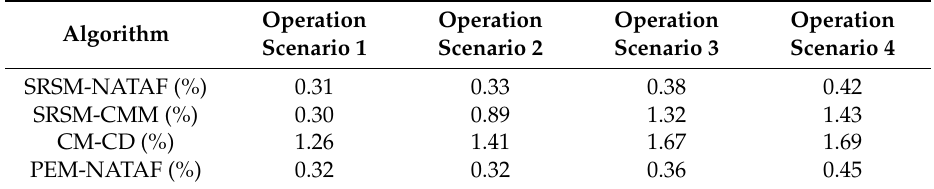
Table 5. The average errors of mean values of the DC bus voltages in the four different operational scenarios examined.